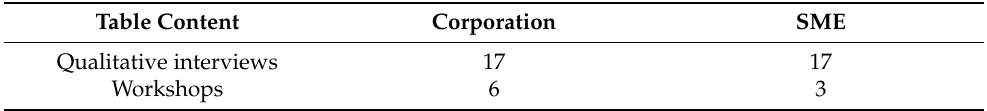
Table 1. Empirical data within our secondary analyses. Table Content Corporation SME Qualitative interviews